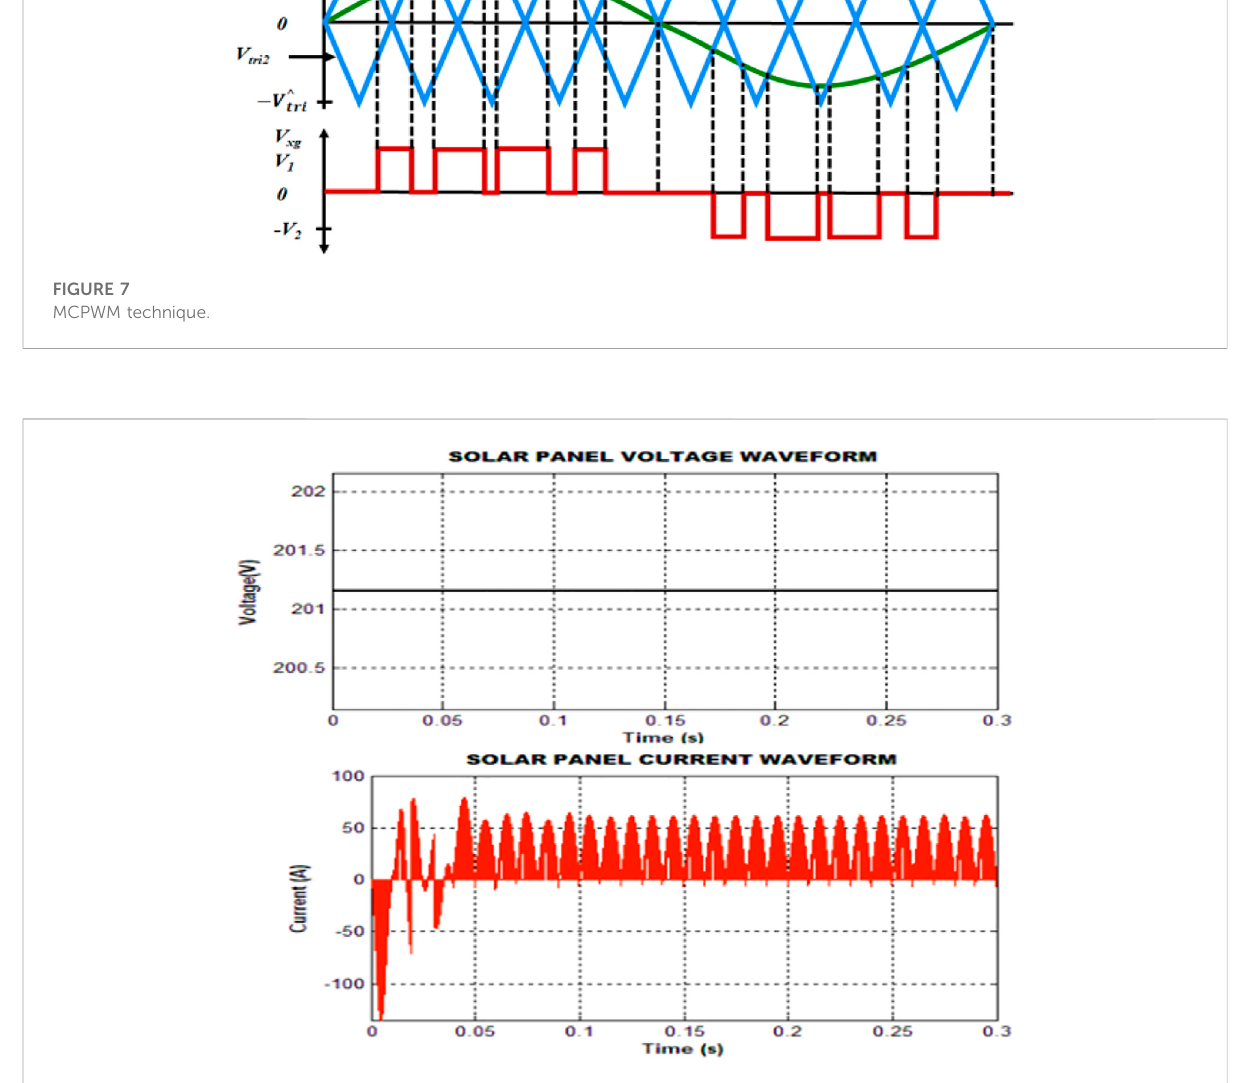
FIGURE 8 Parameters of the solar